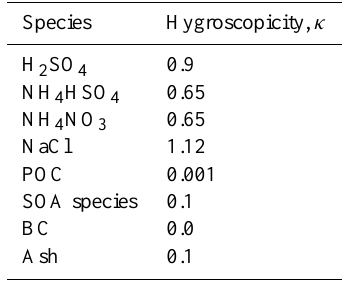
Table 1. Hygroscopicity values, κ , for individual model